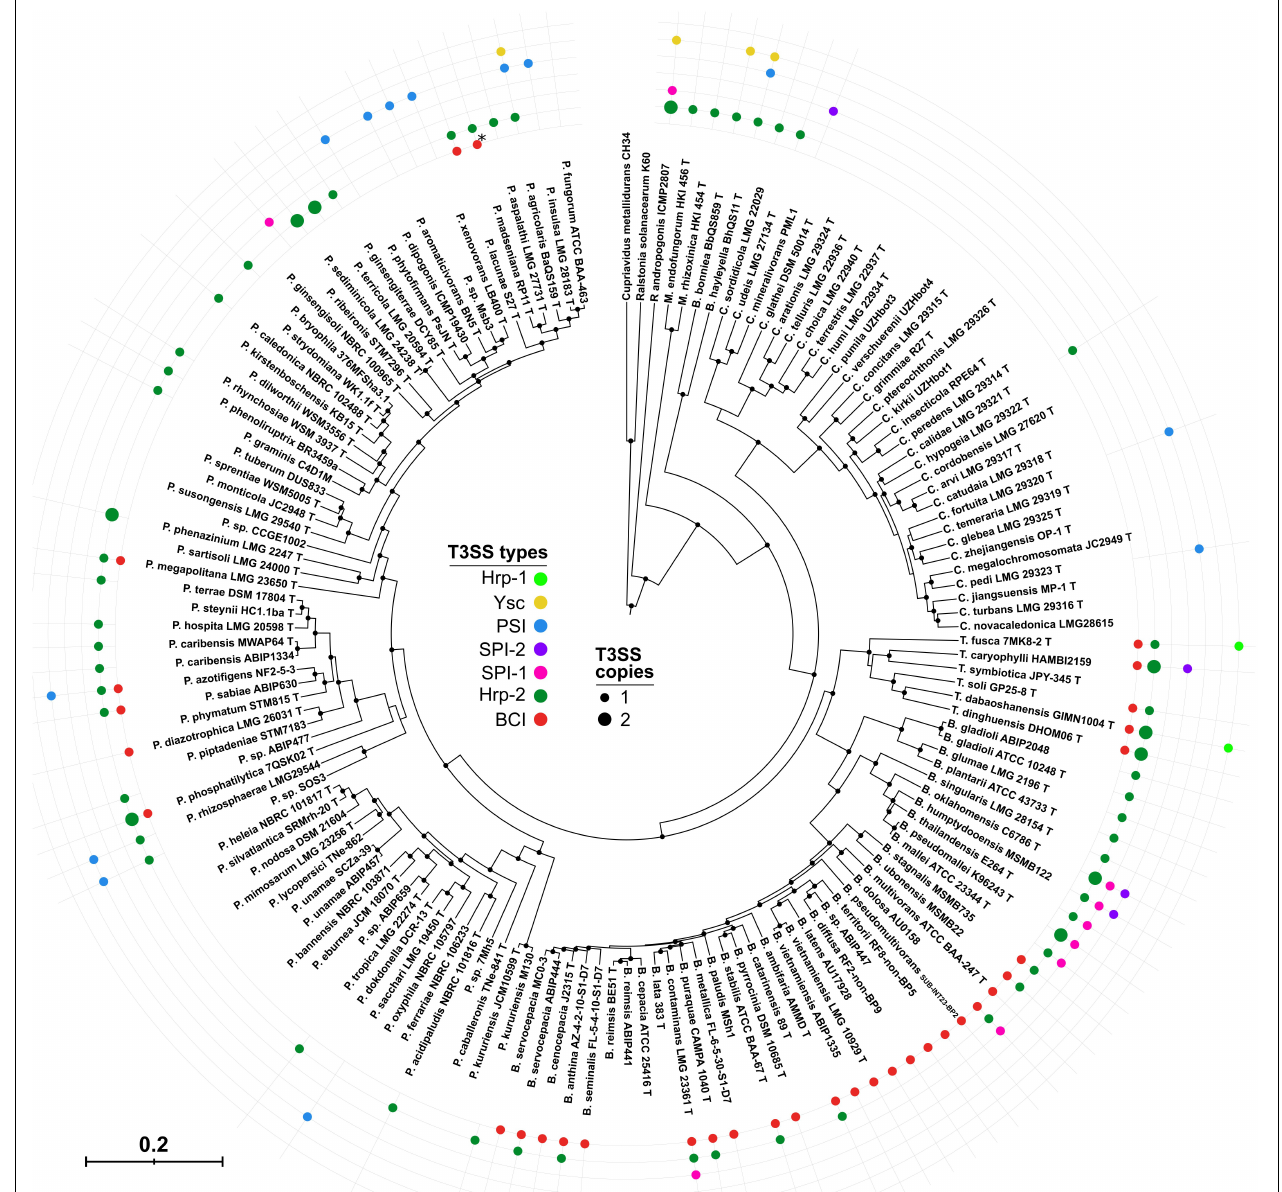
FIGURE 3 | Distribution of T3SS types in Burkholderia s.l. species. Nine concatenated coding sequences ( dnaG, ftsZ, glnA, gyrB, pykA, recA, rho, rpoB, and secA ) of 146 Burkholderia s.l. strains were used to infer the Burkholderia s.l. phylogeny using a Bayesian approach. From the outermost circle inwards, colored circles are representative of the presence of an operon coding for the corresponding T3SS. Large Hrp-2 circles indicate the presence of two similar operons in the genome. ∗ P. madseniana displays a peculiar T3SS, Mad, similar to the BCI but phylogenetically